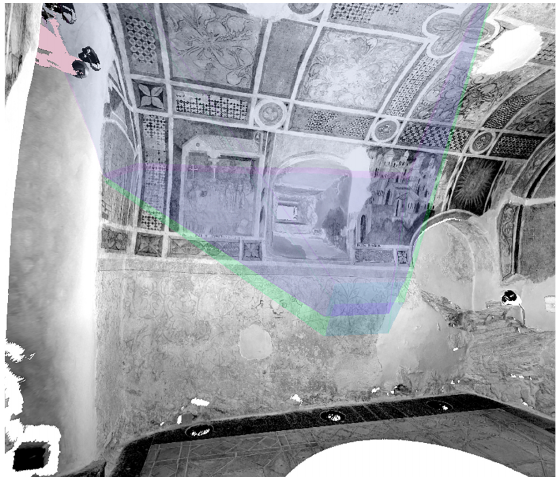
Figure 9. In the image it is possible to view the different position of the projector before (green) and after (blue) the virtual scan